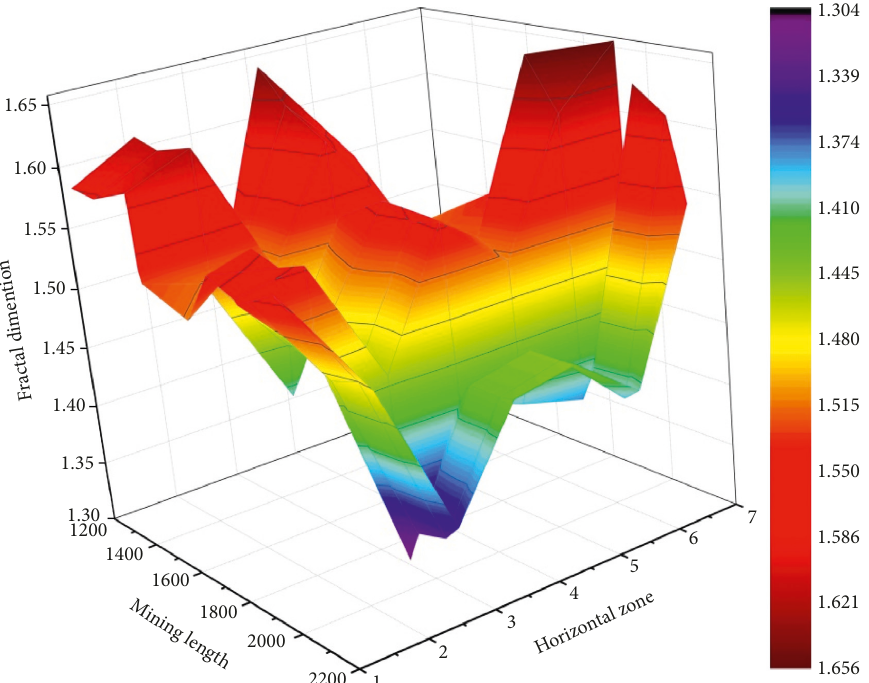
Figure 11: 3D colour map surface of evolution of the fractal dimension of crack network with mining length in different horizontal zones.